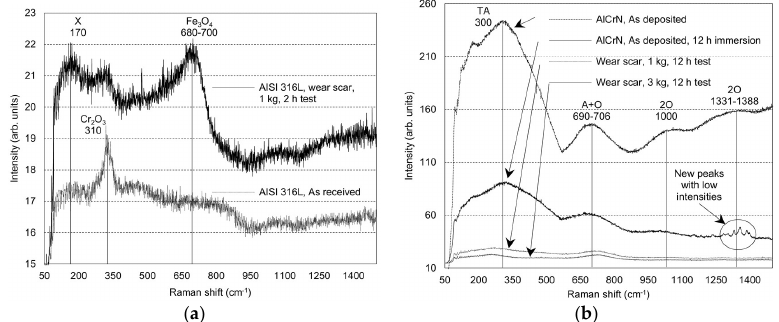
Figure 6. Raman spectra illustrates vibration modes and oxides on pristine surface of AISI 316L and in a wear scar after 2 h (1 kg) tribo-corrosion wear test ( a ); and observed changes of intensities and shifting of peaks on coated specimens before and after 12 h immersion; and after extended (12 h) tribo-corrosion wear tests in 3.5 wt. NaCl % under 1 and 3 kg loads ( b ).